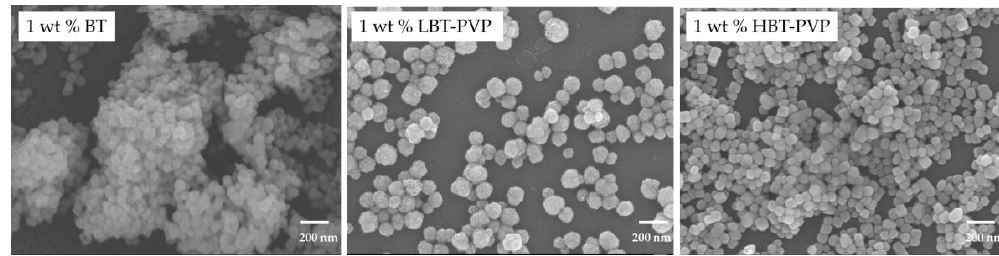
Figure 4. Enlarged SEM images of the thin films prepared 1 wt % BT, LBT-PVP, and HBT-PVP in EtOH coated on PET.